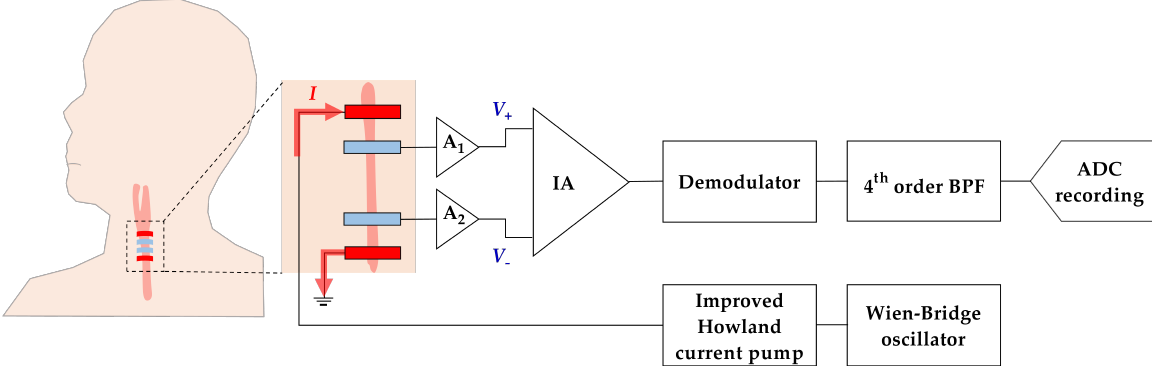
Figure 3. IPG system consists of two pairs of electrodes, two pre-amplifiers, instrumentation amplifier, demodulator, 4th order bandpass filter, Wien-Bridge oscillator, and improved Howland current pump.